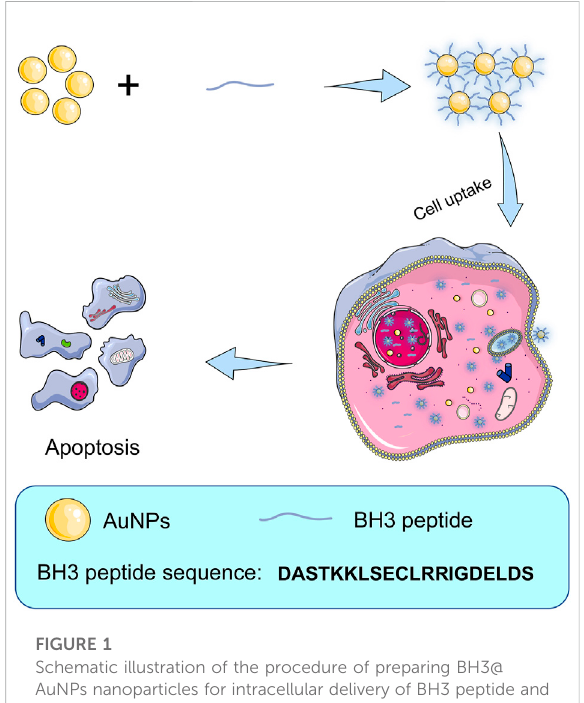
FIGURE 1 Schematic illustration of the procedure of preparing BH3@ AuNPs nanoparticles for intracellular delivery of BH3 peptide and induce cell